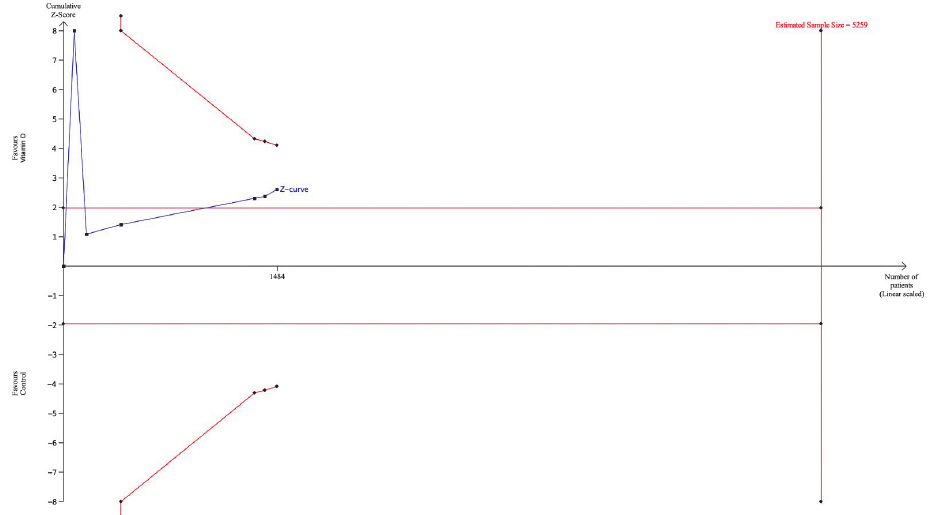
Figure 5. Trial sequential analysis of the false-positive association of protective effect of vitamin D supplementation with mortality in patients hospitalized with COVID-19. The cumulative z-curve is inside the futile boundaries, suggesting that further studies are necessary to confirm the